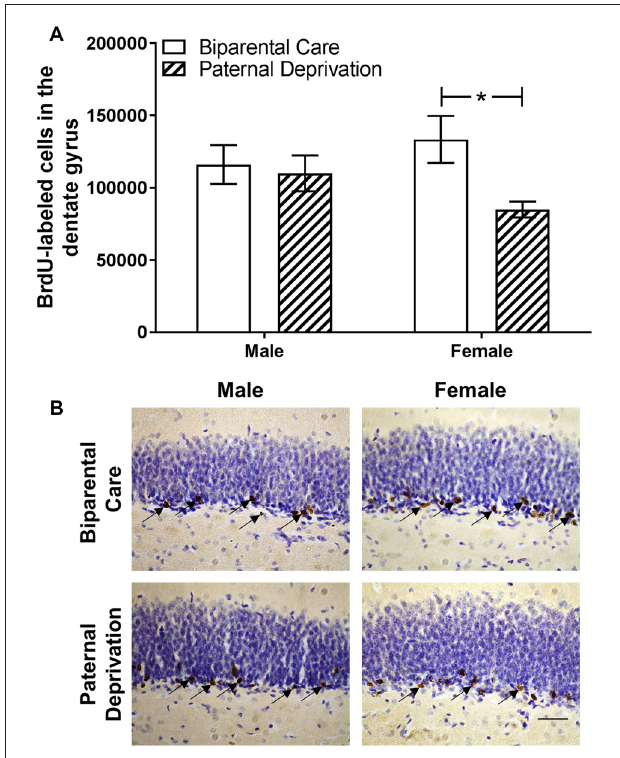
FIGURE 3 | Paternal deprivation (PD) reduces new cell survival in the hippocampus of female, but not male, young adult California mouse offspring. (A) Short-term survival of bromodeoxyuridine (BrdU)-labeled cells was determined in California mouse young adult male and female offspring reared by both parents (biparental care) or reared by mother alone (PD) from postnatal day (PND) 1 to weaning PD. PD reduced the number of BrdU-labeled cells in the dentate gyrus of female, but not male, offspring. N sizes: biparental male, 6; biparental female, 6; PD male, 9; PD female, 6. Bars represent mean ± SEM. ∗ p ≤ 0.05. (B) Representative photomicrographs (40 × oil magnification) of BrdU-labeled cells in the dentate gyrus of the hippocampus. Scale bar = 40 µ m. Arrows point to BrdU-labeled